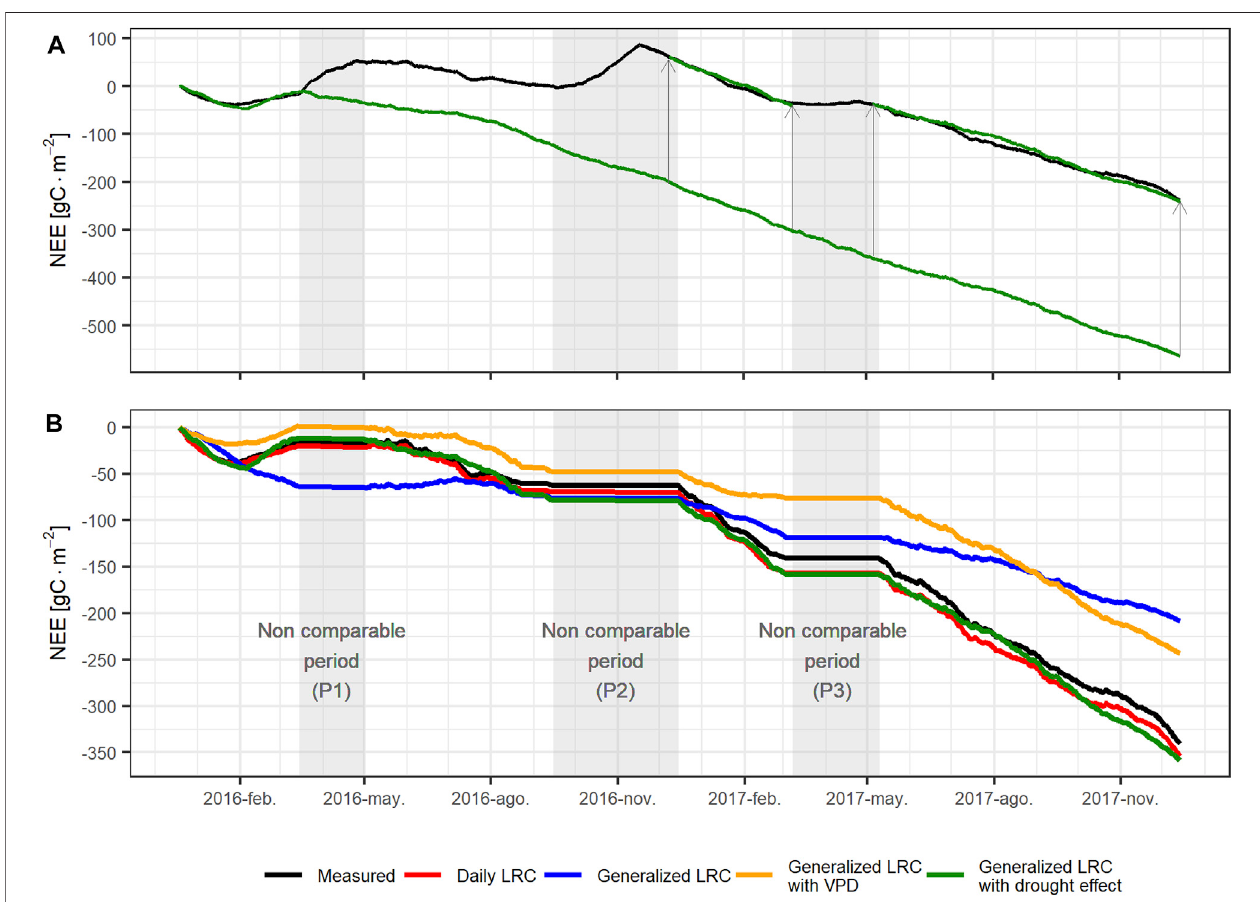
FIGURE 9 | Comparison of measured carbon accumulation and model variant estimations: (A) measured carbon accumulation (black) and generalized LRC with drought effects (green) (see text for details) the entire measurement period; (B) Comparison excluding unavailable data and dry to wet season transition periods (gray shade).Alongwithobservations (black),thiscomparison includes the followingmodels: dailyLRC (red), generalizedLRC (blue), generalized LRC withVPD(orange),and generalized LRC with drought effects